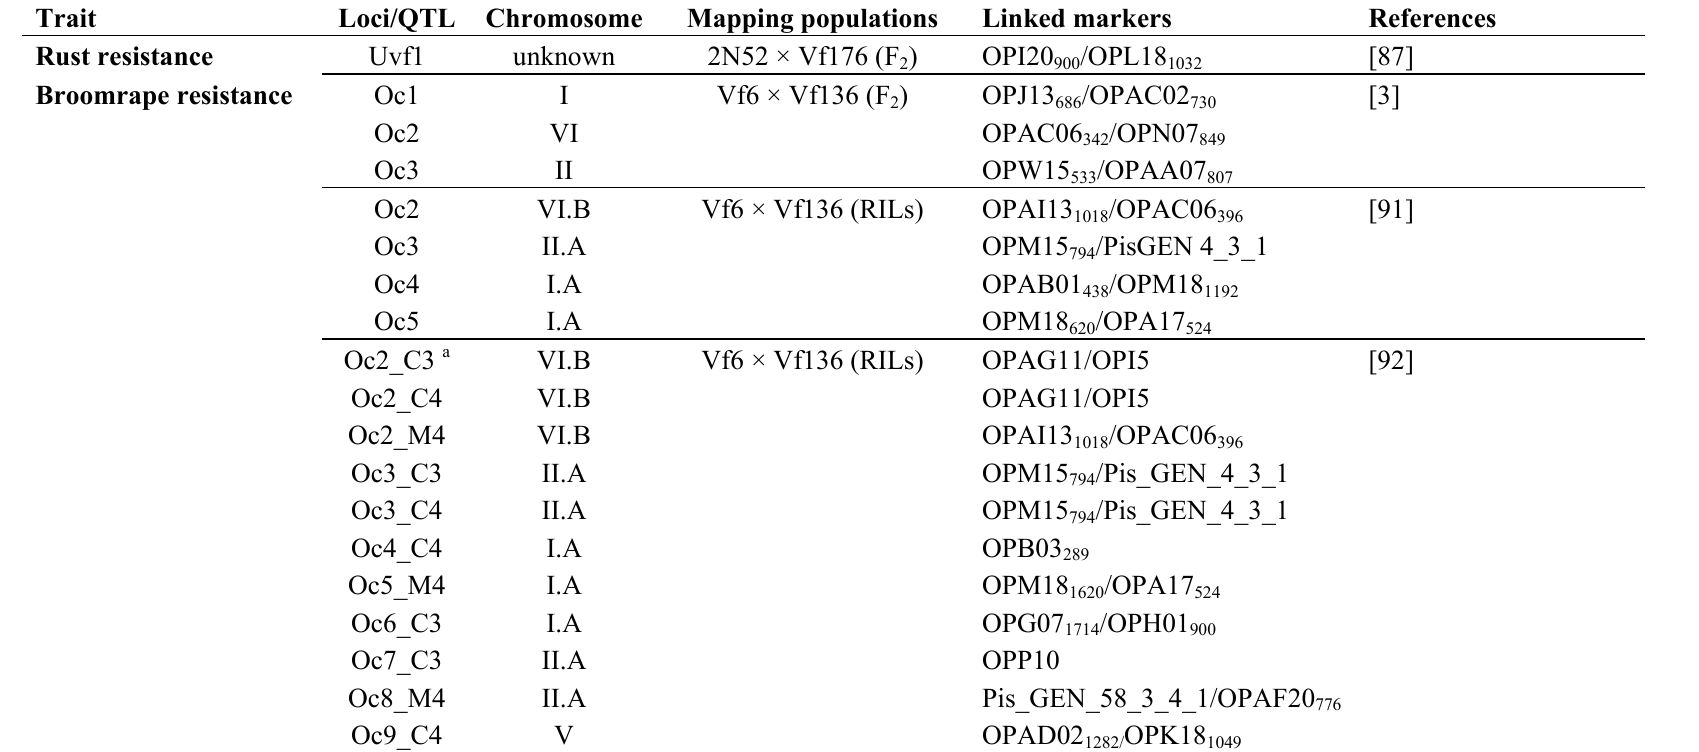
Table 1. Update of the molecular markers associated to gene(s)/QTLs of agronomic interest reported so far in faba bean (Main source: [9]).